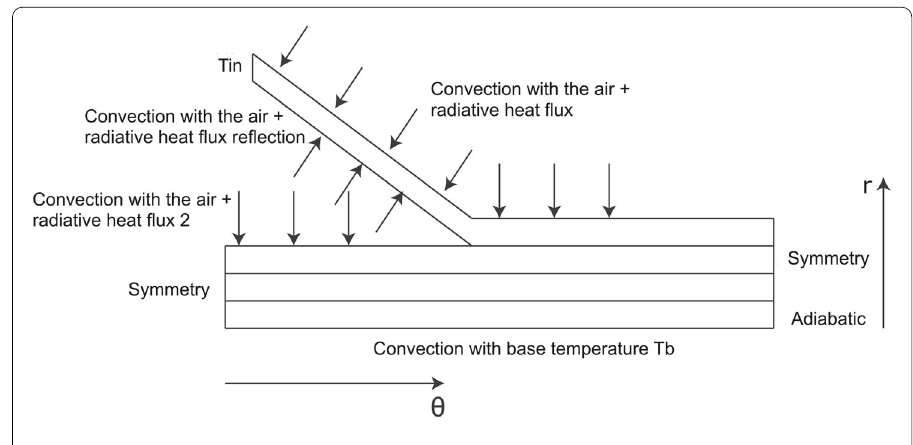
Fig. 4 The modeling of the ATP process